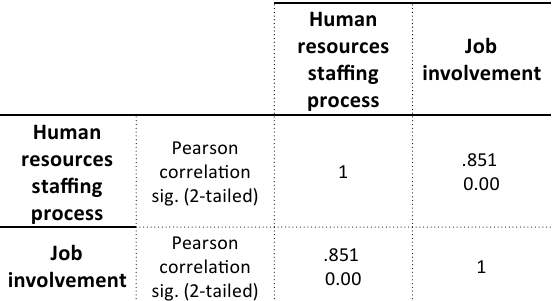
Table 3. Correlation matrix